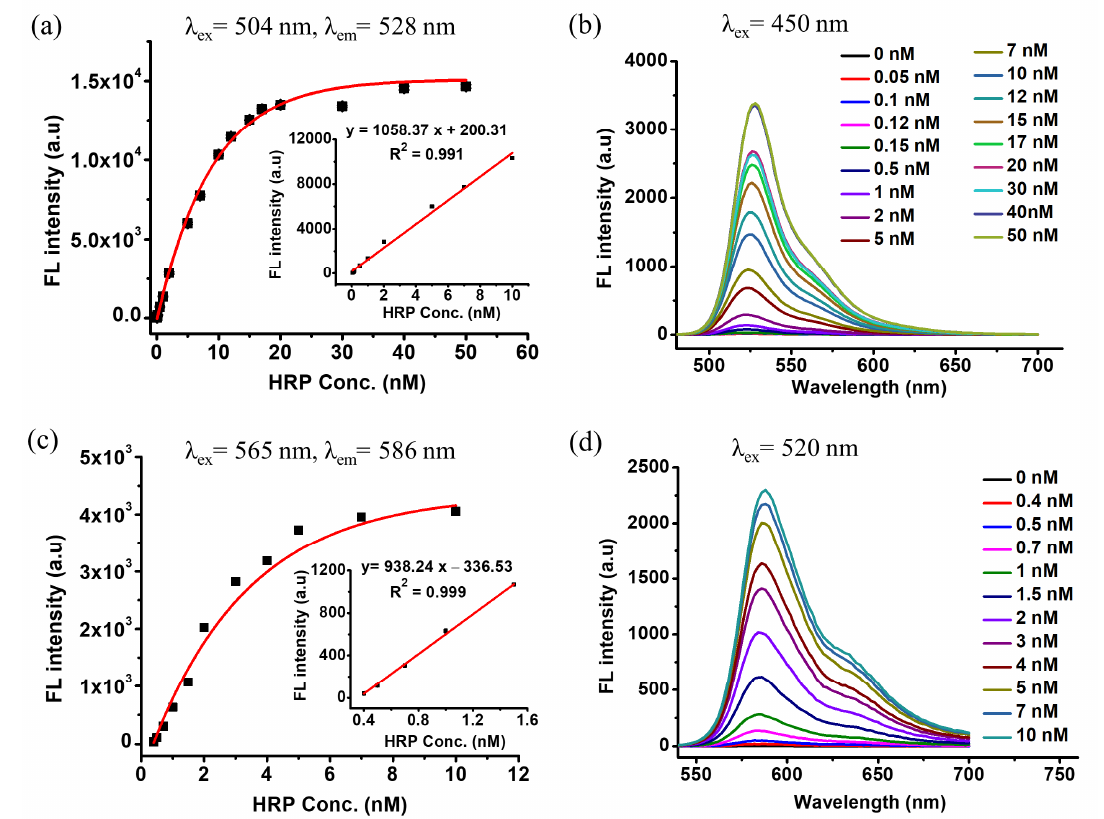
Figure 4. ( a ) The detection curve of DCFH-1 in the presence of series concentrations of HRP; the insert stands for a linear relationship between the intensity and HRP concentration. ( b ) Full fluorescence spectra of DCFH-1 reaction solution upon HRP detection, which was excited at 450 nm. ( c ) The detection curve of Amplex red in the presence of series concentrations of HRP; the insert stands for a linear relationship between the intensity and HRP concentration. ( d ) Full fluorescence spectra of Amplex red reaction solution upon HRP detection, which was excited at 520 nm.